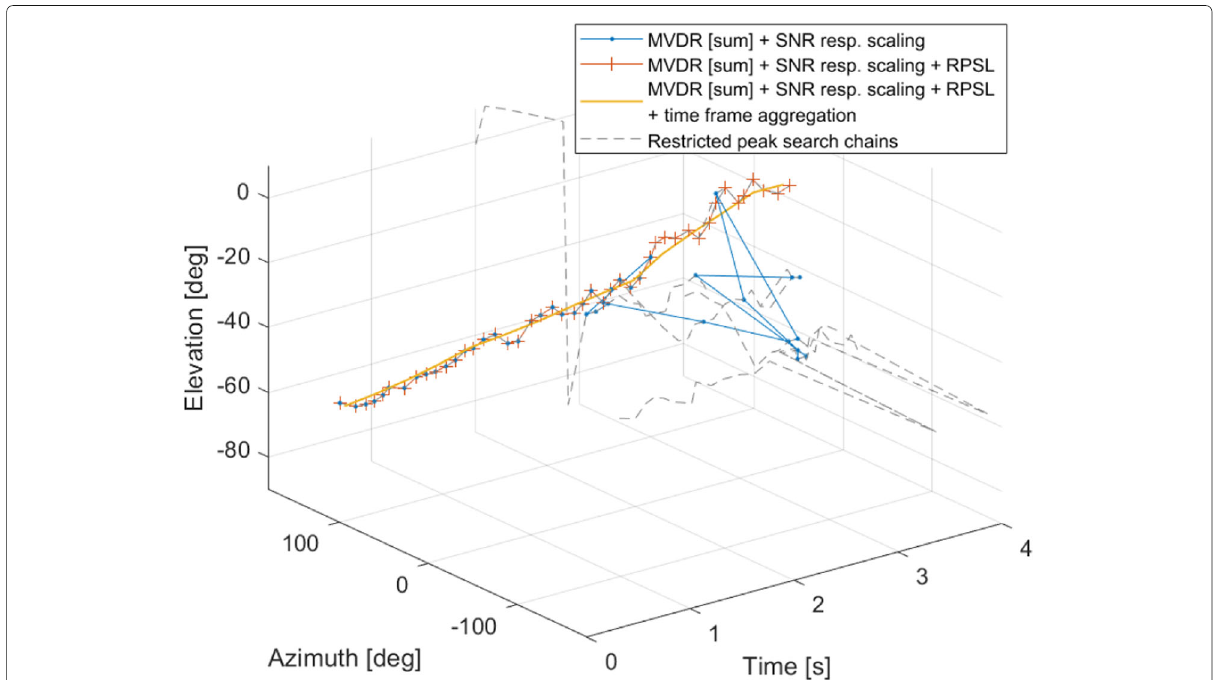
Fig. 5 Example of localisation performance with SNR response scaling (Section 3.2) and RPSL post-processing (Section 3.3) applied. (SPCup flying UAV broadband sound source (task 2) case 11 [1])